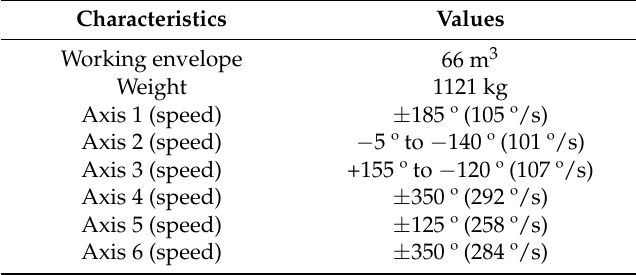
Table 1. Robot characteristics for the KUKA KR90 R3100.